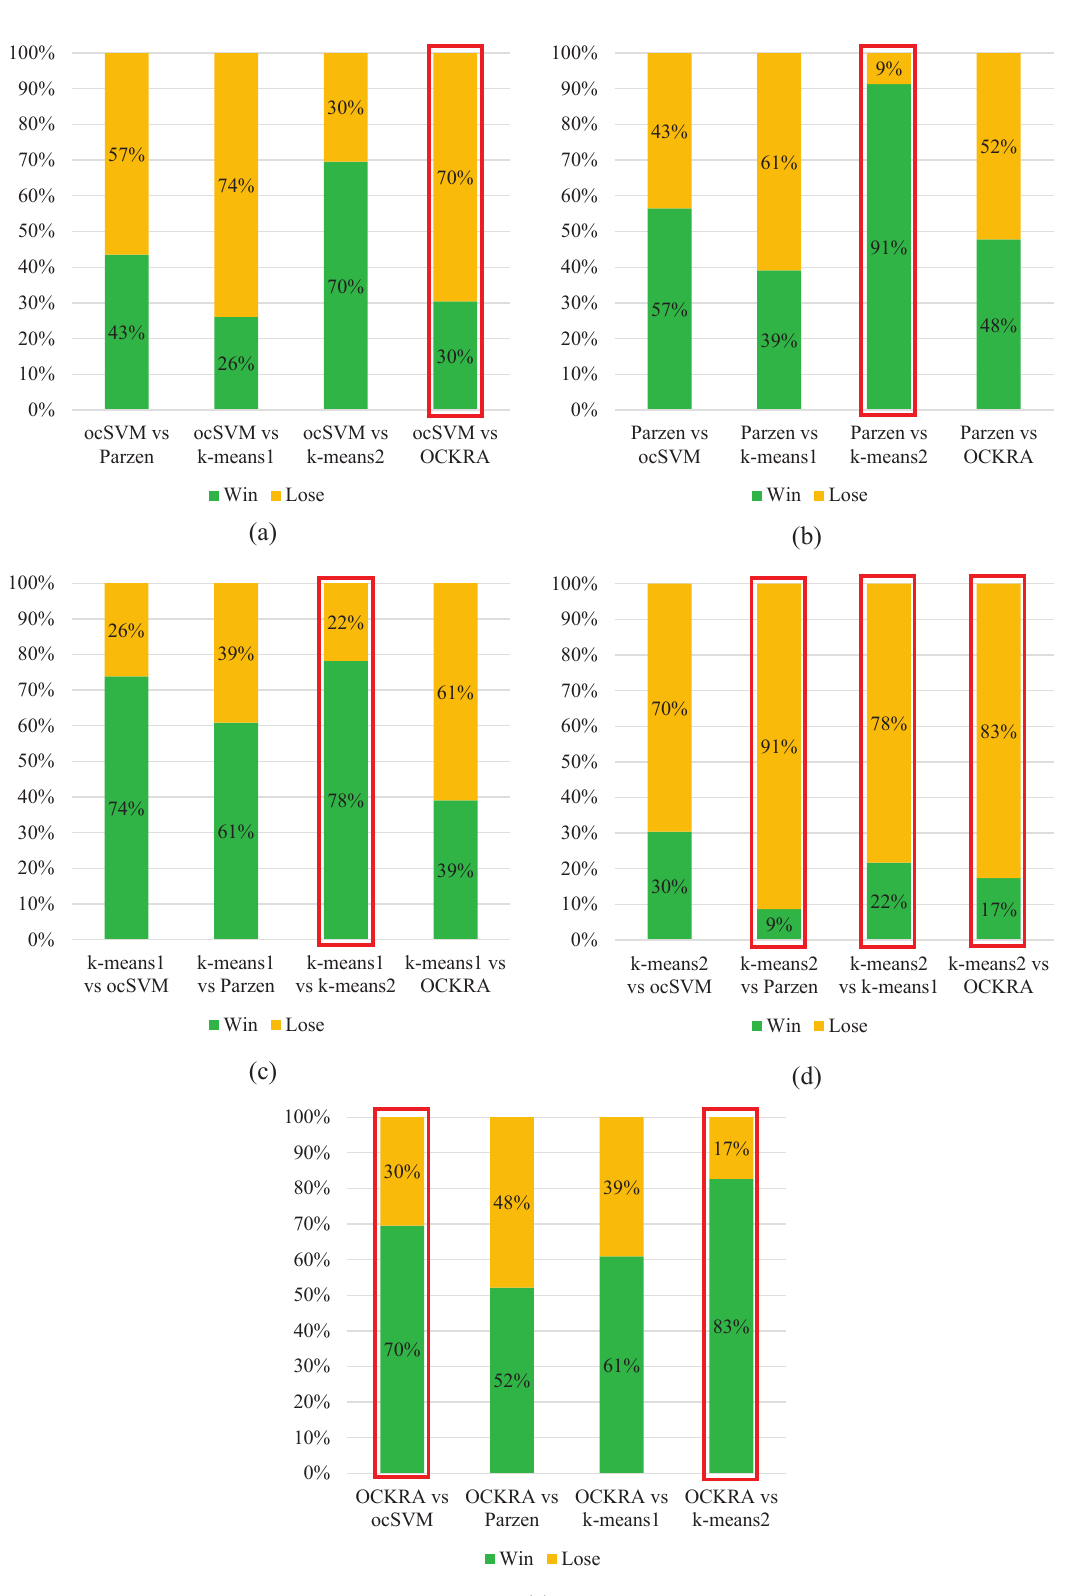
Figure 2. Pairwise comparisons of the algorithms based on the AUC results. AUC winning count: ( a ) ocSVM versus all; ( b ) Parzen versus all; ( c ) k-means 1 versus all; ( d ) k-means 2 versus all; ( e ) OCKRA versus all. The columns with red outer rectangles indicate significant differences according to Wilcoxon’s signed-rank test at a significance level of